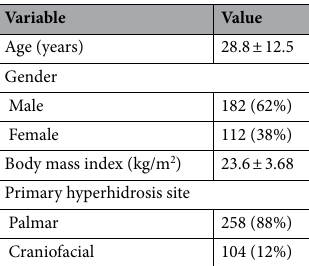
Table 1. Patient characteristics. Values are number (%) or mean ± standard deviation.